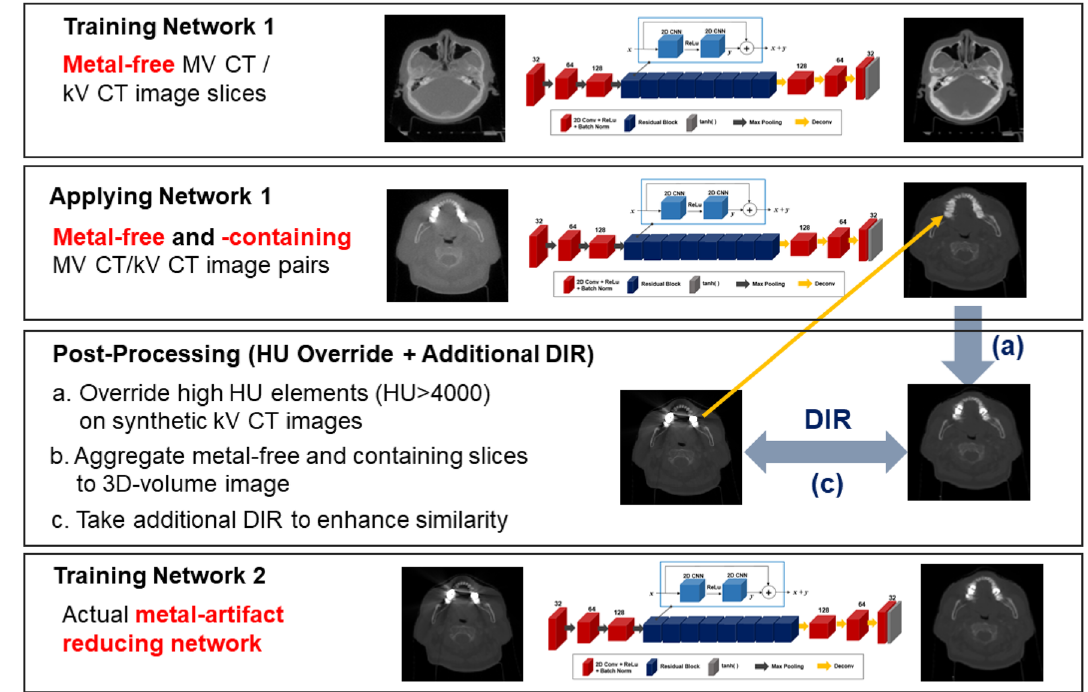
Figure 3. Flowchart of the additional image processing to the generated synthetic kV CT to improve image similarity between the prospective input and output images in Network